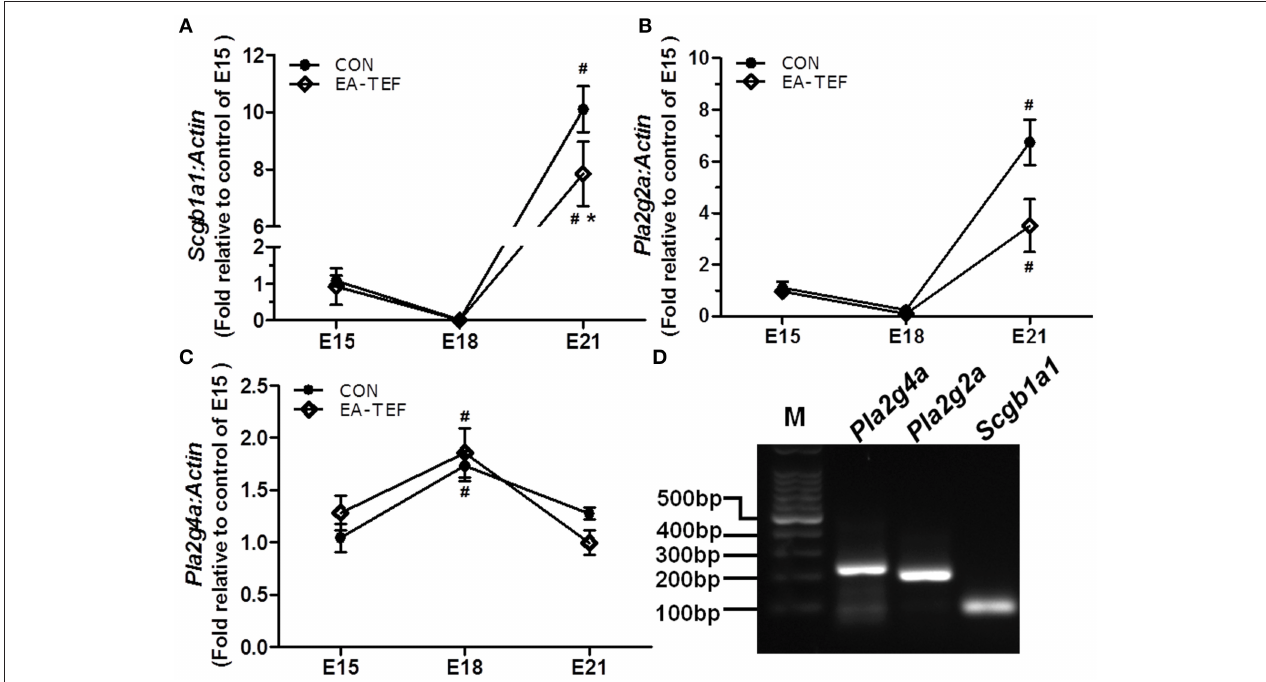
FIGURE 4 | Effect of doxorubicin on Scgb1a1 and Pla2 expression in fetal lungs. (A–C) Expression of Scgb1a1 and its downstream targets Pla2g4a and Pla2g2a mRNAs in the fetal lungs of both groups were assayed by quantitative PCR and (D) the specificity of the PCR products was confirmed visually on 2% agarose gels. Expression is reported relative to E15 controls and normalized against a β -actin housekeeping gene. Data are means ± SEM of five rats, * P < 0.05, EA-TEF vs. age-matched controls, inter-group; # P < 0.05, E18 or E21 vs. E15, within group.